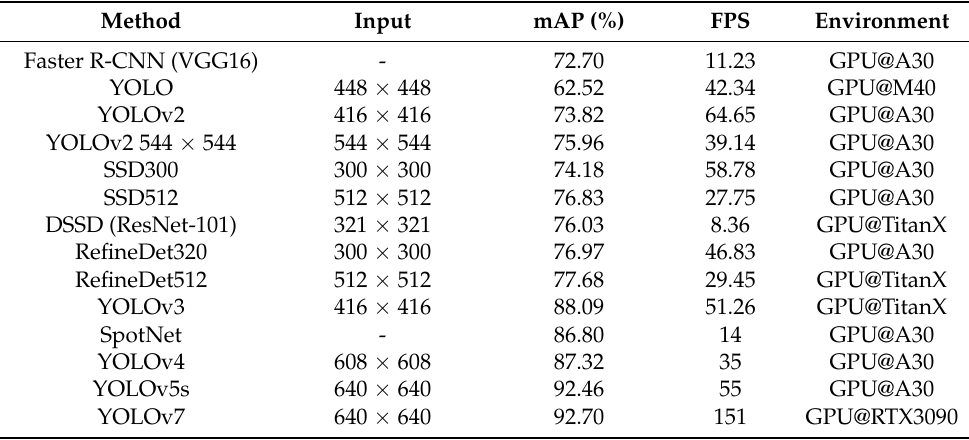
Table 1. Test performance of different algorithms on UA-DETRAC